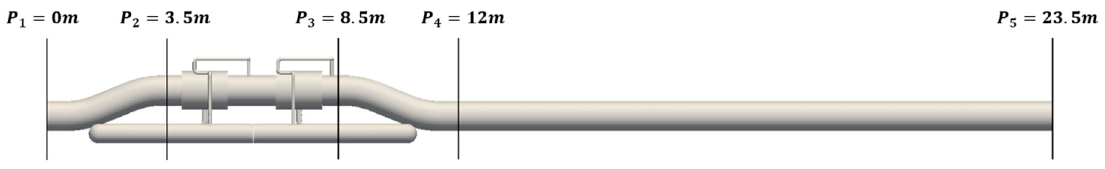
Figure 3. Computational geometry of the first design of the separator. The vertical lines show various reference points and their corresponding distance in the x-direction from the inlet. The pipe length required for fully developed flow is indicated at point P5 and is located at 23.5 m (approximately 25 diameters) downstream of the inlet.